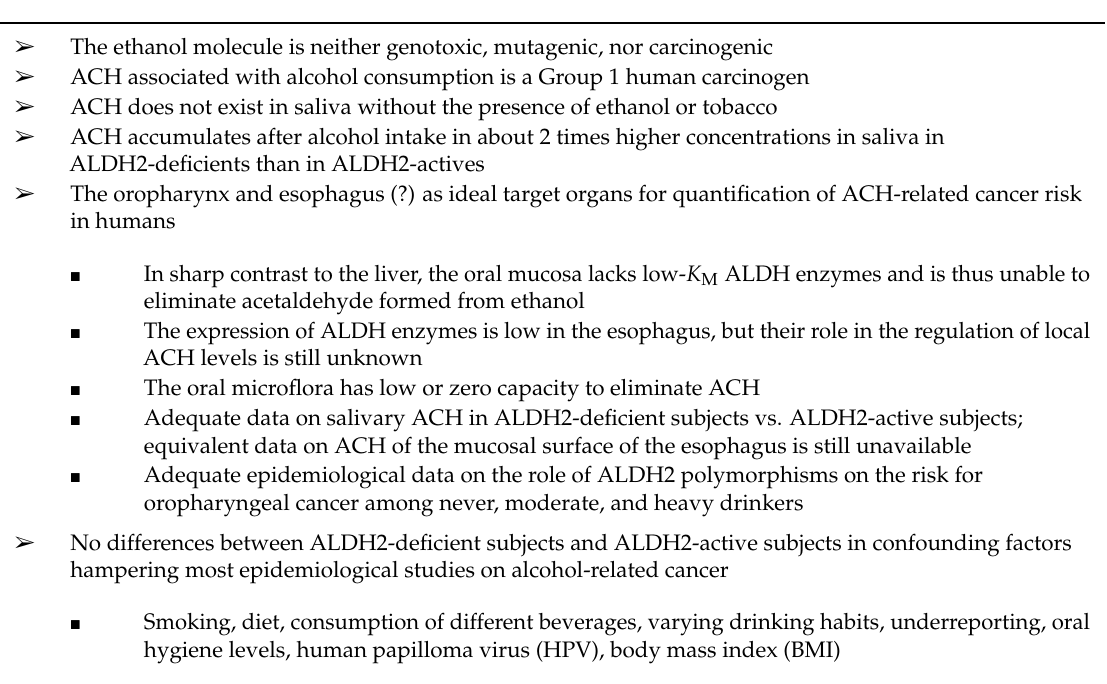
Table 1. Main characteristics of the gene mutation-based human model for the quantitative assessment of acetaldehyde (ACH) carcinogenicity in alcohol-consuming aldehyde dehydrogenase (ALDH) 2-deficient subjects compared to ALDH2-active subjects